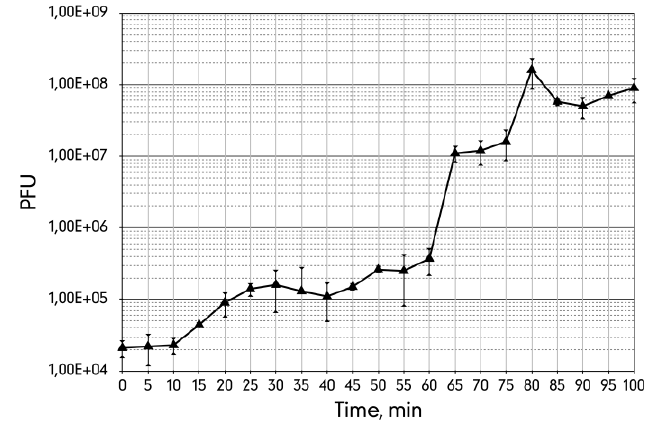
Figure 3. The single burst experiment curve of the bacteriophage 9g grown on E. coli C600 host at 37 °C with agitation at 250 rpm.